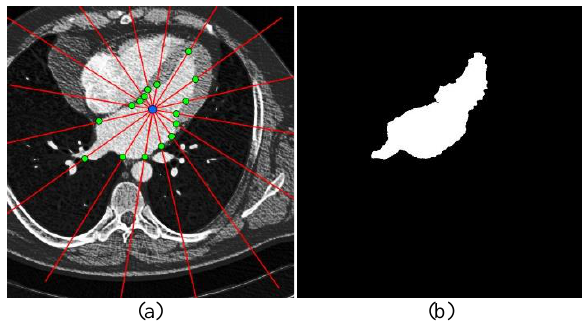
Figure 6. Set of border points obtained by the classifier (a) and a mask obtained after post-processing step